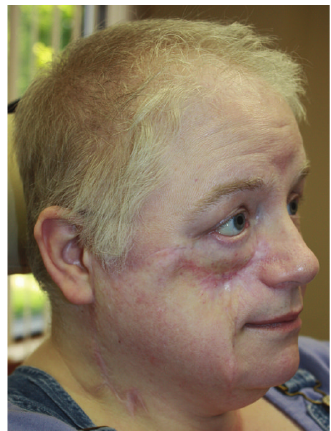
Figure 2: Case 3, one year after completion of external beam radiation therapy. One can see the smooth skin texture. Cheek deformity and combination of paralytic/cicatricial ectropion right lower lid are evident. Reconstruction of these deformities planned in the near